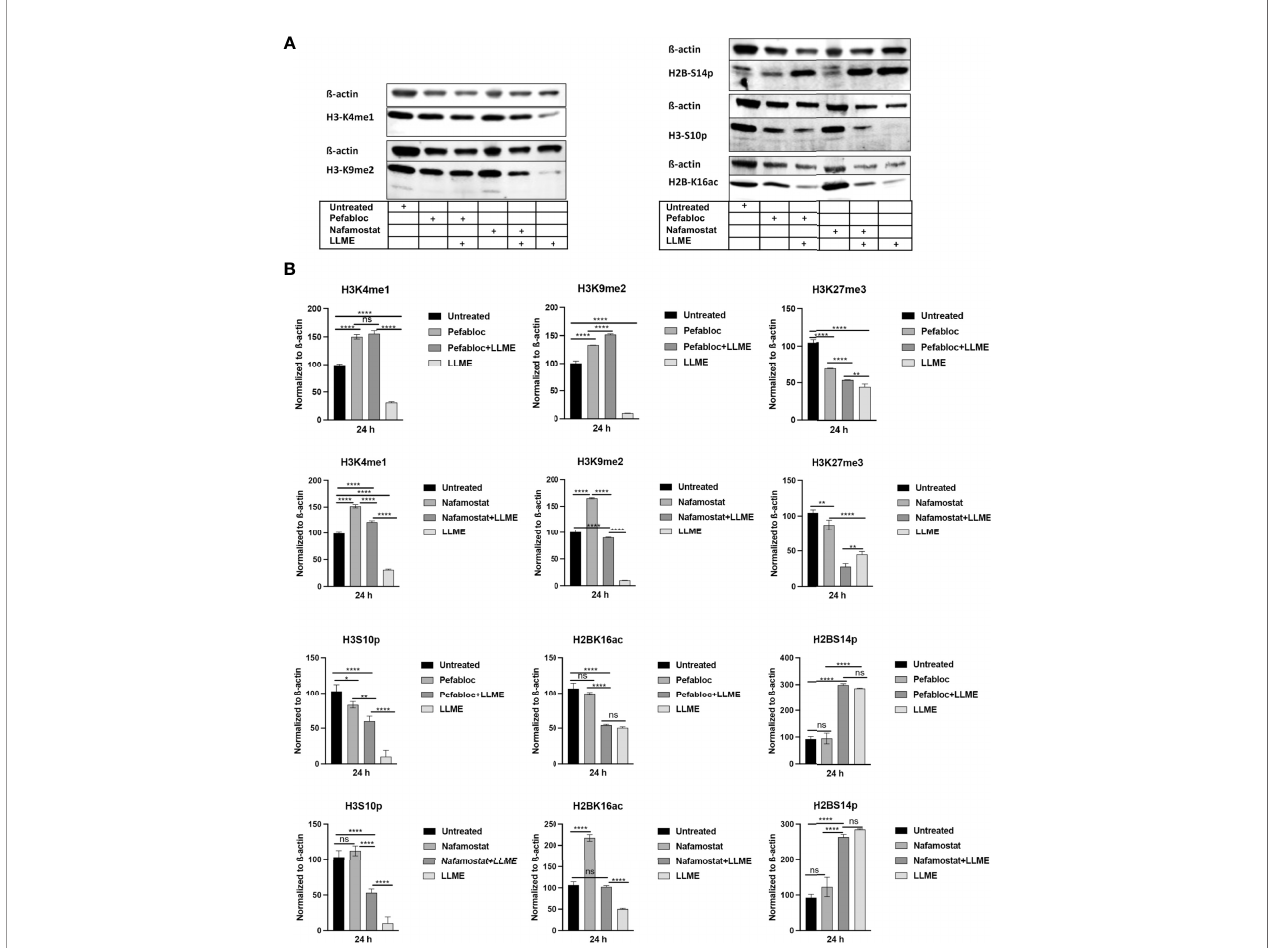
FIGURE 5 | Tryptase inhibition blocks the effect of cytotoxic agents on the levels of epigenetic histone marks in mast cell leukemia cells. (A) HMC-1 cells (0.5 x 10 6 cells/ml) were either left untreated or treated with either Pefabloc SC (Pefa; general serine protease inhibitor) or nafamostat (Nafa; tryptase inhibitor) for 30 min prior to incubation with LLME (400 m M) for 24 h. Samples corresponding to equal numbers of cells were subjected to Western blot analysis for levels of the H3K4me1, H3K9me2, H3K27me3, H2BS14p, H3S10p and H2BK16ac marks, with ß-actin used as loading control. (B) Quanti fi cation of the levels of the H3K4me1, H3K9me2, H3K27me3, H2BS14p, H3S10p, and H2BK16ac marks, normalized to the loading control. The presented data are representative of at least two independent experiments and are given as mean values ± SEM (n=3). *p ≤ 0.05; **p ≤ 0.01; ****p ≤ 0.0001. ns, not signi fi